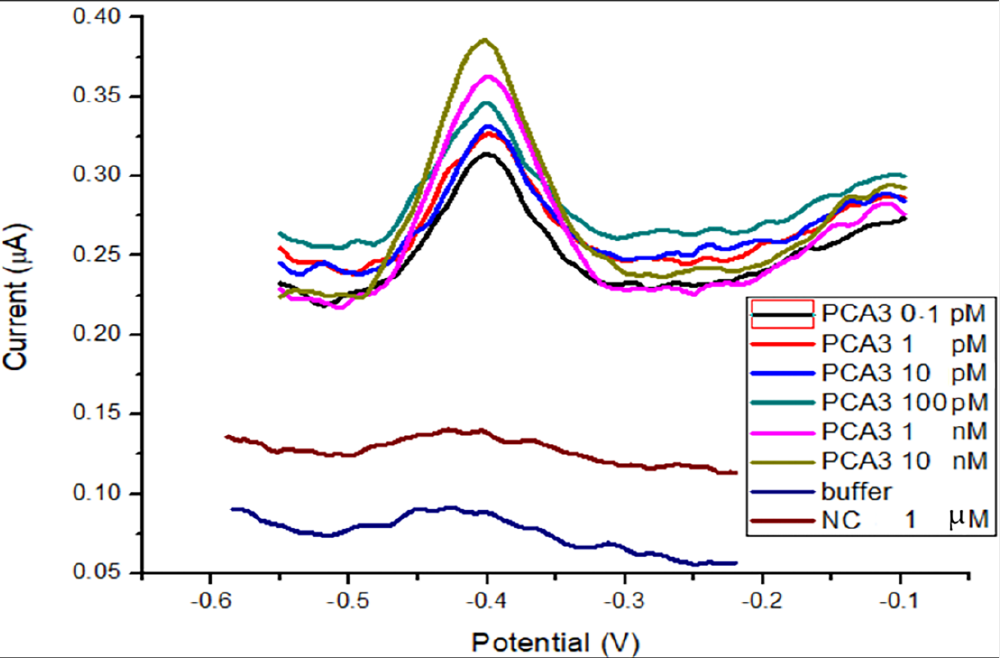
Figure 2. DPVs were recorded on electrodes functionalised with an MB-labelled aptamer in buffer solution containing different concentrations of PCA3. DPVs in pure buffer solution and negative control using scrambled PCA3 are shown for comparison.